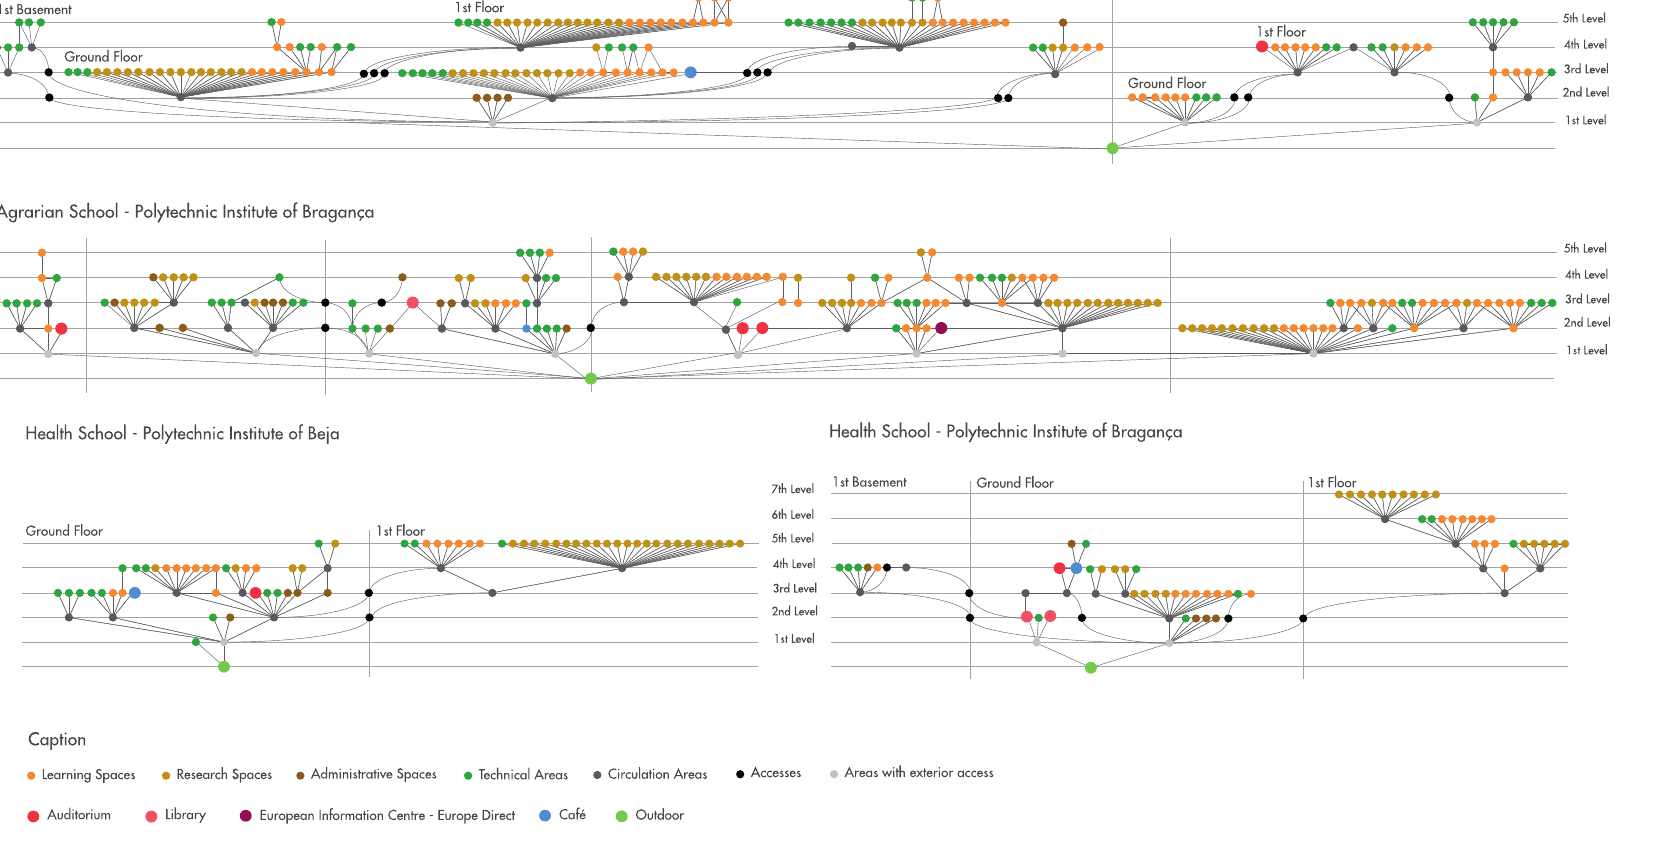
Figure 6. Justified graph of the Agrarian and Health Schools, Polytechnic Institutes of Beja and Bragança .